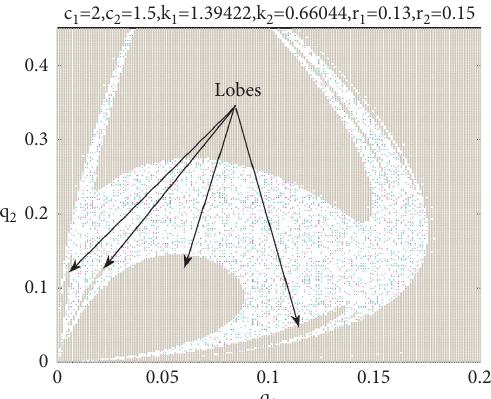
Figure 6: The Lobes constructed with period of 3-cycle at: c � 1 . 5 , r � 0 . 13 , r � 0 . 15 , k � 1 . 39422 and k 2 , c 2 1 2 1